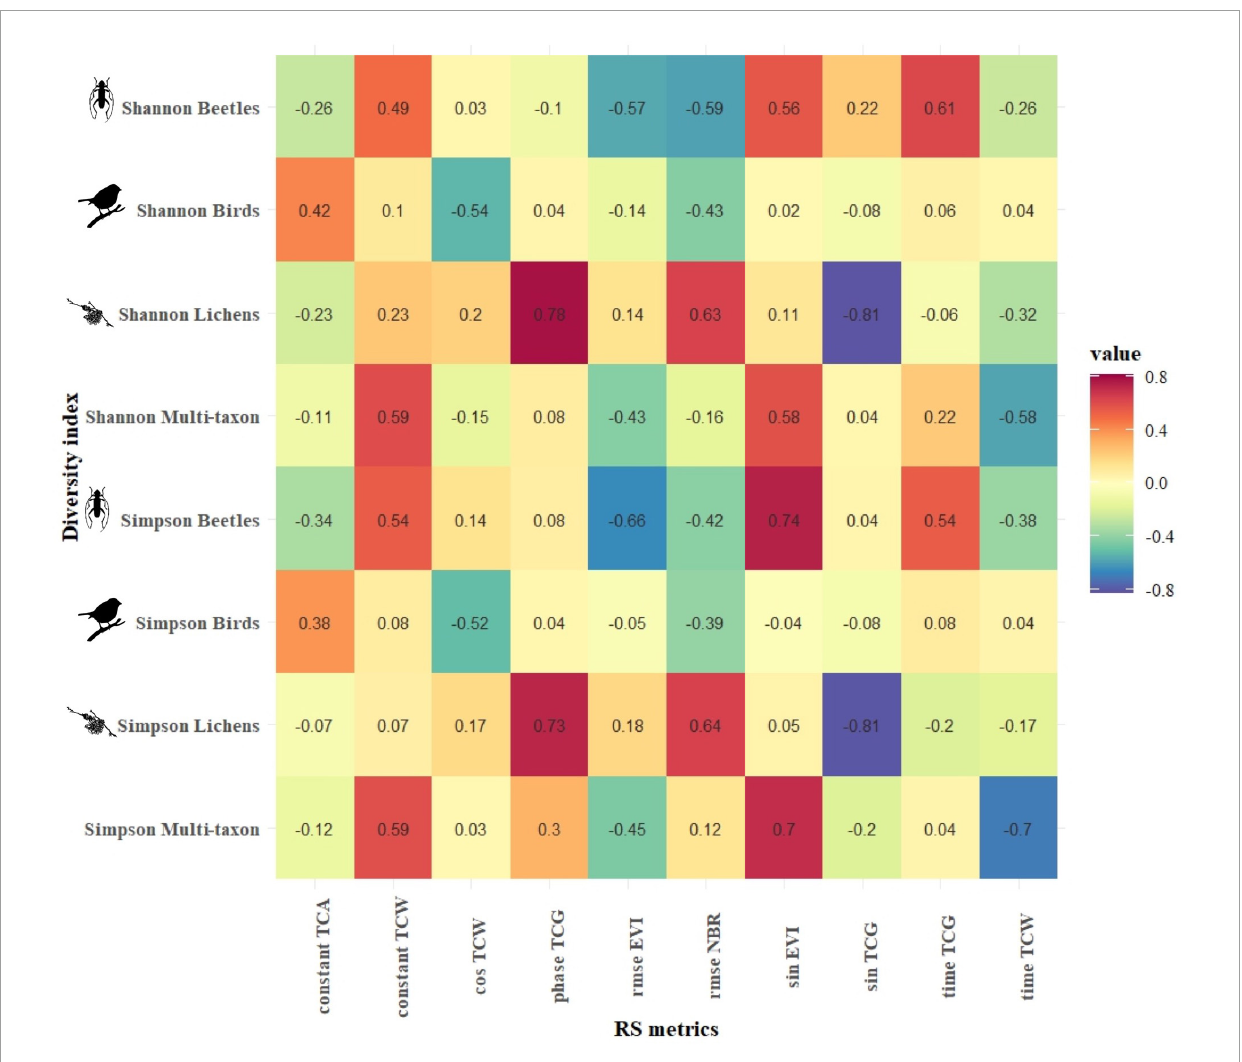
FIGURE5 GSML: Pearson’s product-moment correlation (r) between biodiversity indices of each taxon (y-axis) and the best Sentinel-2-derived temporal metrics (x-axis). The color in each cell represents the correlation value between the corresponding variables in the two axes.